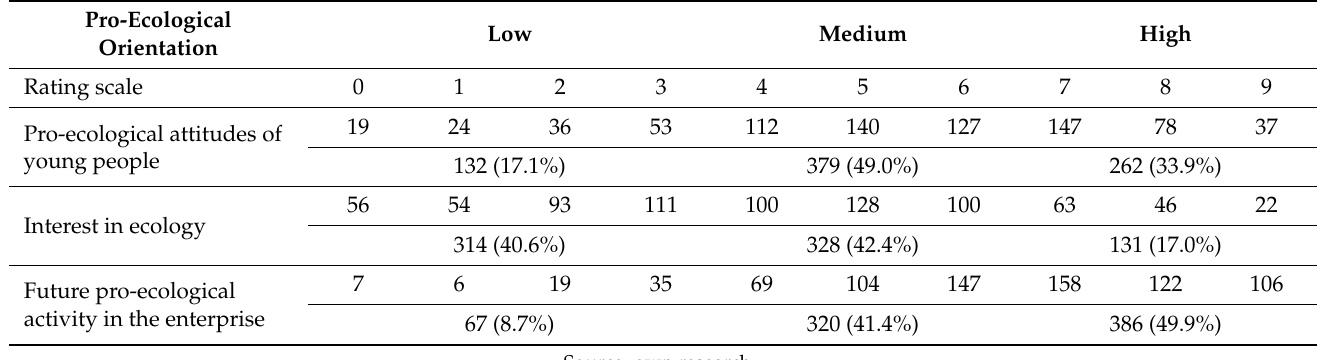
Table 1. Pro-ecological orientation of the younger generation—the current state and preferences regarding future pro- ecological activities in enterprises.